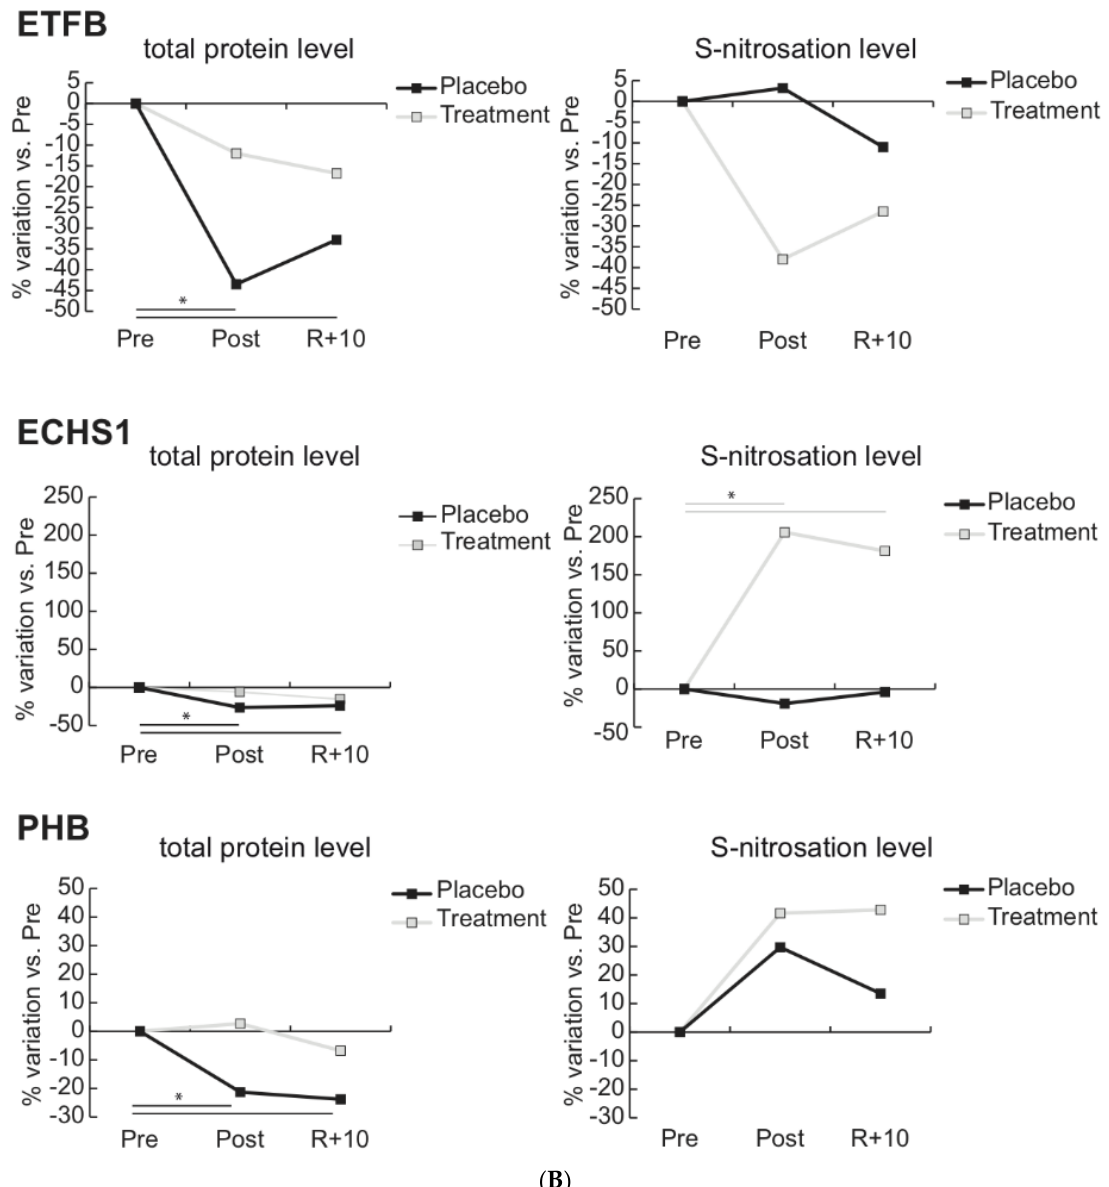
Figure 5. ( A , B ) Total abundance and S -nitrosated protein level of mitochondrial proteins. Line charts illustrating protein abundance and S -nitrosation level variations (%) of succinate dehydrogenase (ubiquinone) flavoprotein subunit (SDHA), aconitate hydratase (ACO2), voltage-dependent anion-selective channel protein 1 and 2 (VDAC1, VDAC2), electron transfer flavoprotein subunit beta (ETFB), enoyl-CoA hydratase (ECHS1), and prohibitin (PHB) in post-bedrest (Post) and recovery (R + 10) compared to pre-bedrest (Pre) condition in untreated controls (Placebo, black lines) or in subjects under antioxidant treatment (Treatment, gray lines) (* = significant difference, ANOVA and Tukey, n = 5, p -value ≤ 0.05).